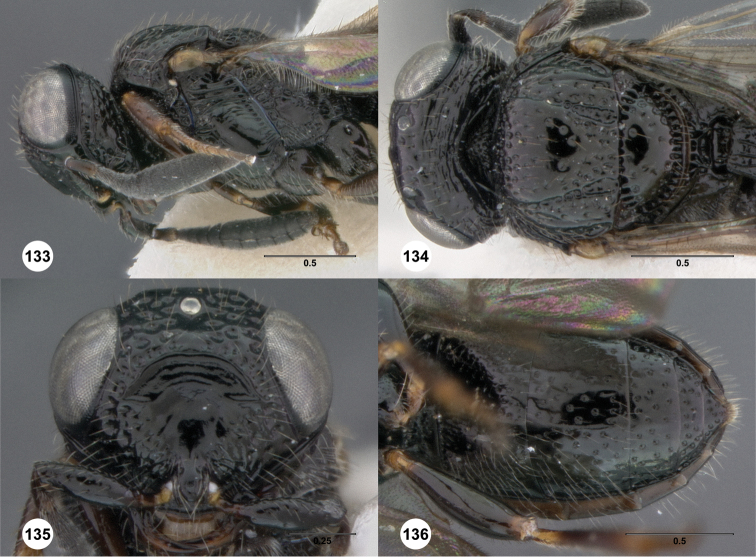
Oxyscelio hamorum sp. n., holotype female (OSUC 359626) 133 Head and mesosoma, lateral view 134 Head and mesosoma, dorsal view 135 Head, anterior view. Paratype female (462591) 136 Metasoma, ventral view. Morphbank53